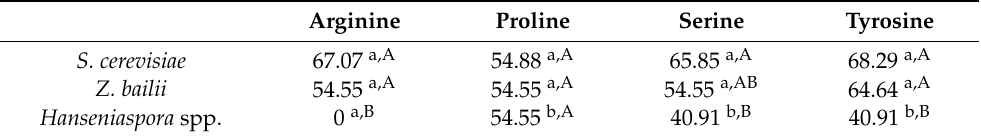
Table 3. Yeasts positive to decarboxylation in recovery percentage (%). Small letters indicate signifi- cant differences throughout lines, while capital letters indicate significant differences in a column (Mann-Whitney, p <